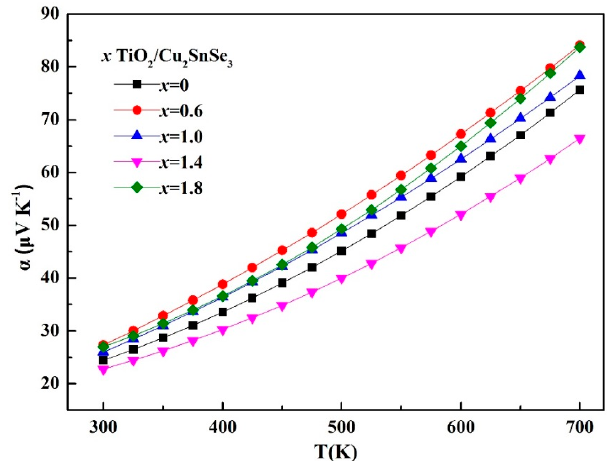
Figure 7. Temperature dependence of Seebeck coefficient for the TiO 2 /Cu 2 SnSe 3 composites.